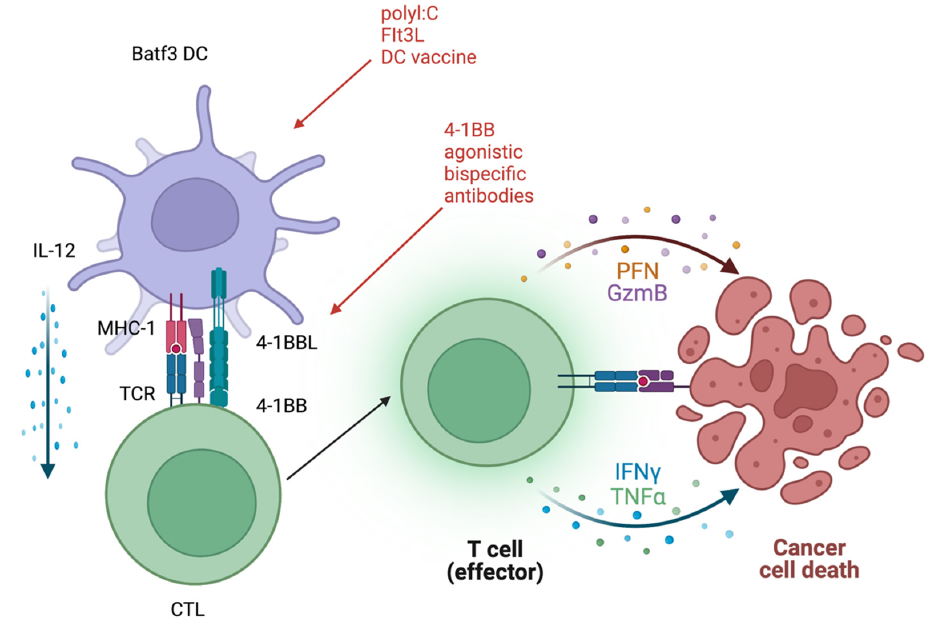
Figure 4. Batf3 DC-CTL interaction tumor microenvironment. In the tumor microenvironment, repriming of CTLs via Batf3 DCs is mandatory for efficient tumor eradication. Inactive CTLs need co-stimulation with 4-1BB ligand (4-1BBL). Batf3 DCs can provide this signal. Alternatively, 4-1BB-